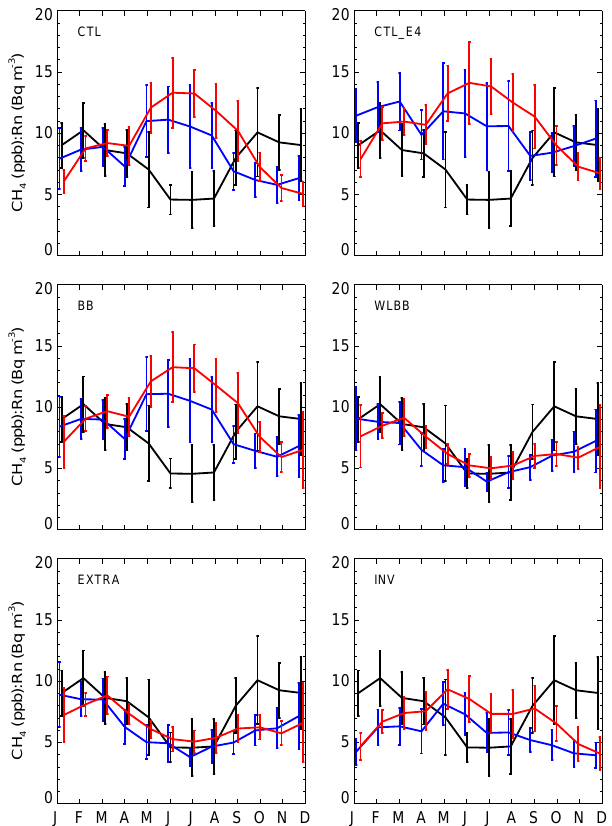
Figure 7. Mean seasonal cycle of residual methane to radon ratios for each of the six methane emission scenarios. Observations are shown in black, ACCESS results in blue and CCAM results in red.